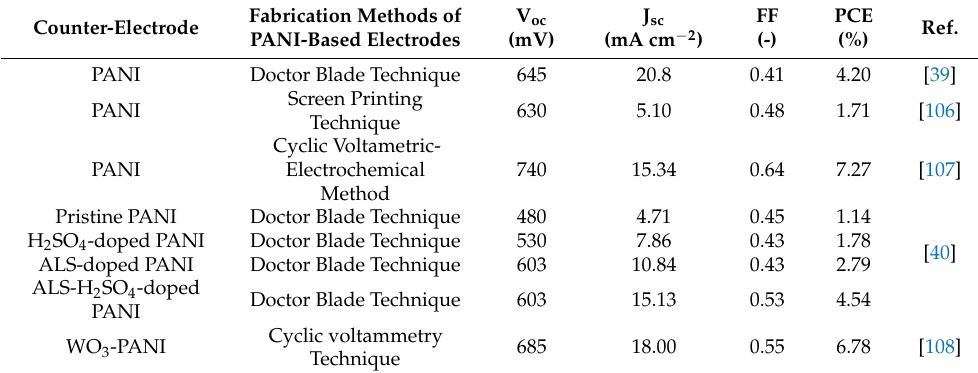
Table 4. Photovoltaic performance parameters of polyaniline and its nanocomposites based on DSSCs